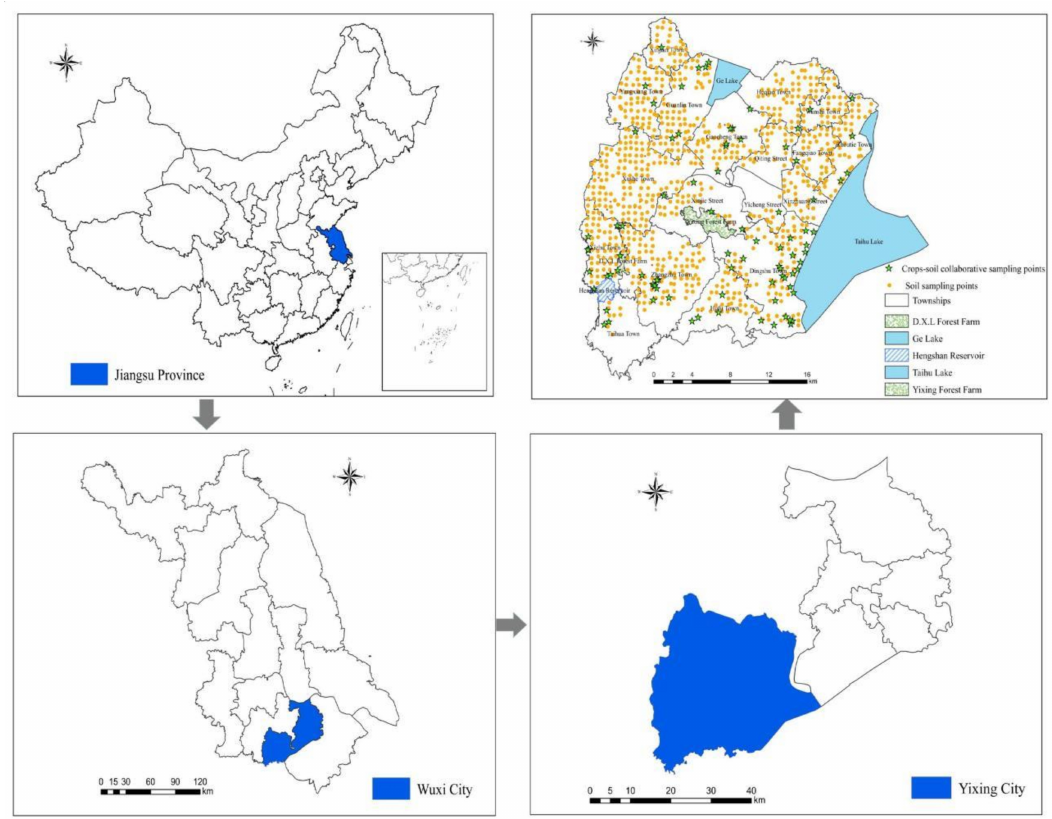
Figure 2. Location and distribution of the sampling points in Yixing